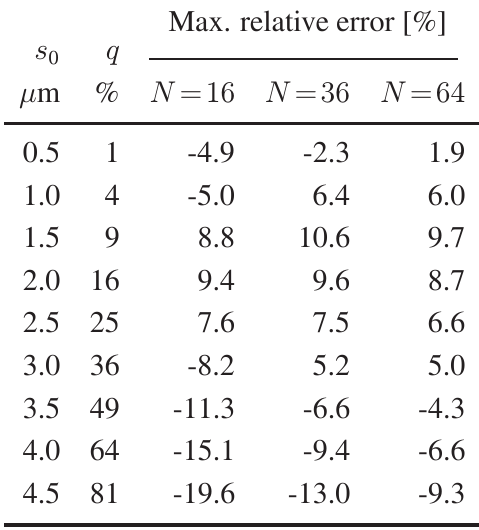
Table 4 . Maximum relative errors in the translational motion damping coef fi cient Z the homogenisation method. Each row includes cases for d = 1 µ m or 2 µ m and h Comparison is made against the 3D simulations with the N-S